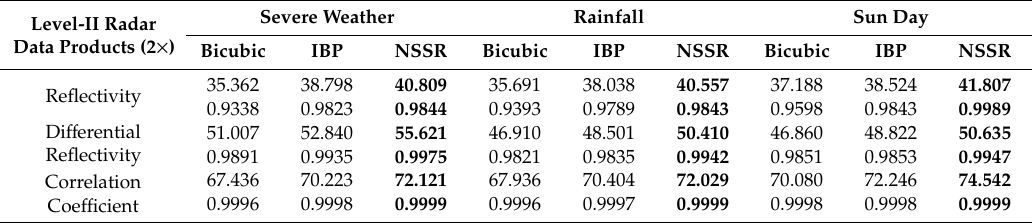
Table 4. Average PSNR (dB) and SSIM results of the reconstructed echo of five groups of level-II XPRAD data.